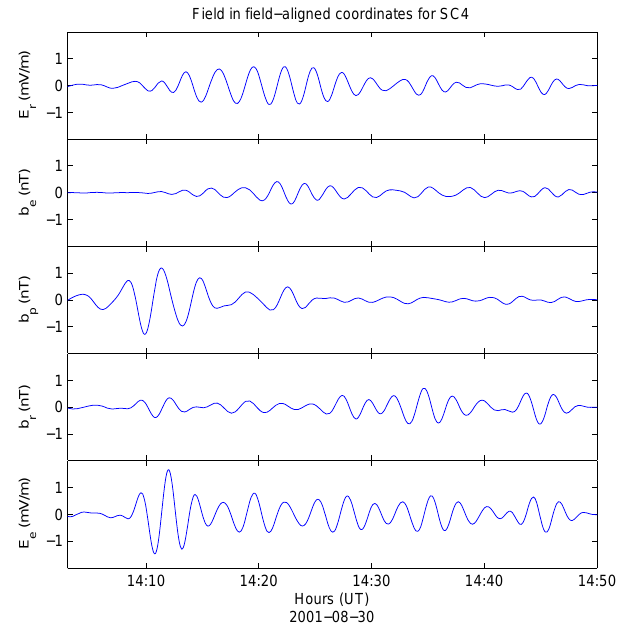
Fig. 5. Field in field-aligned coordinates measured by SC 4. The data have been bandpass filtered in the range